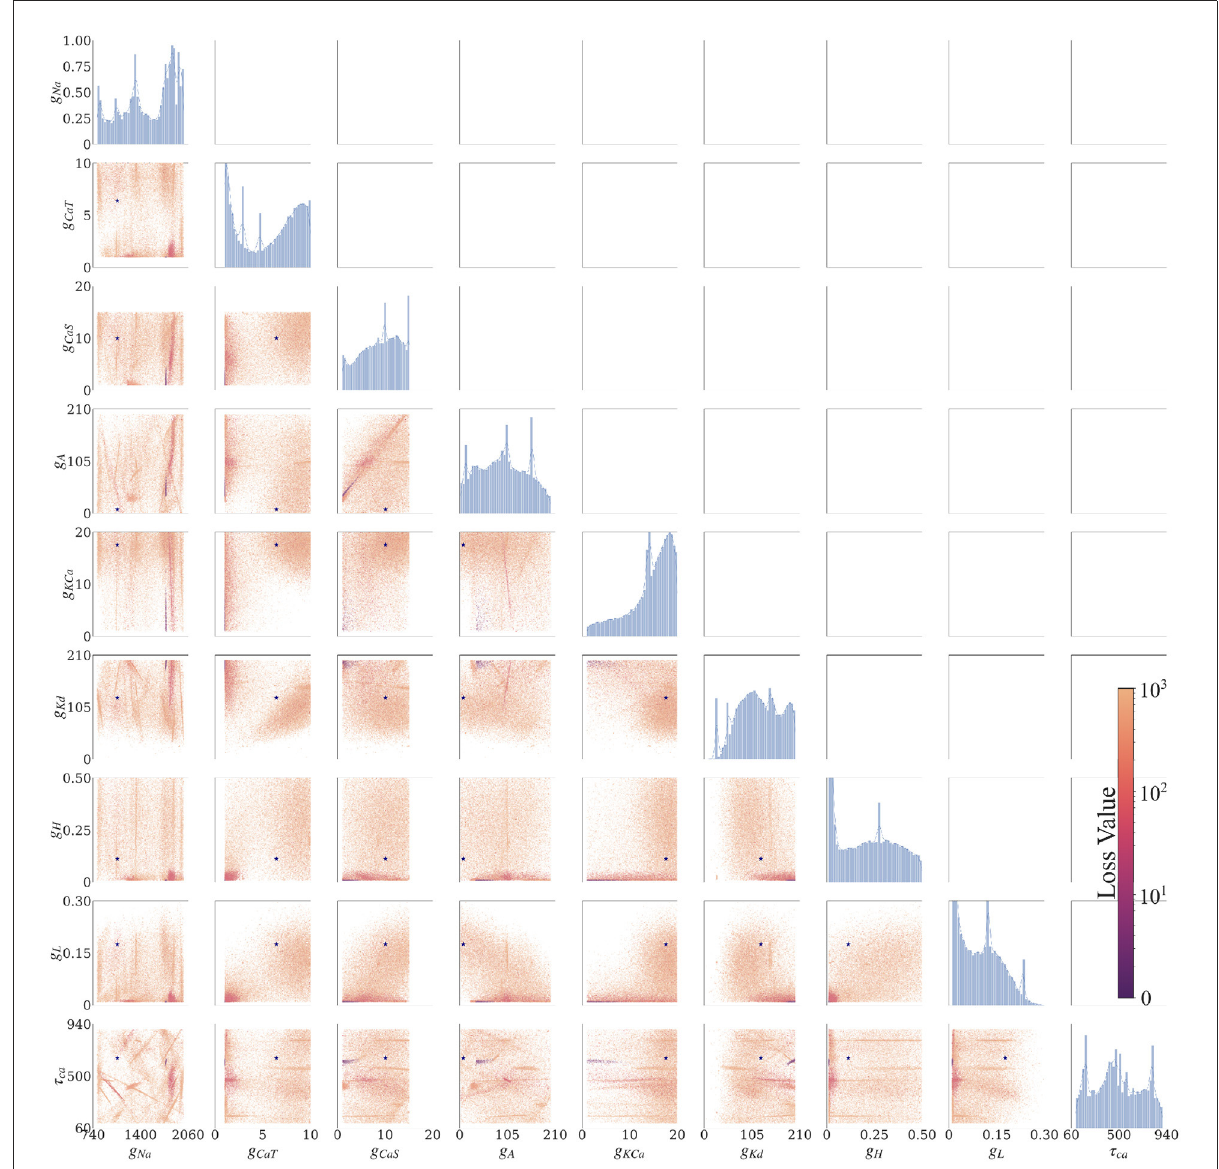
FIGURE4 Solution maps of the posterior for the 9 parameters of the AM model for the aggregate constraint. The diagonal plots show the 1D marginals of each parameter. The x-axis is the search range of the parameter, and the y-axis is the normalized distribution. The remaining plots are the 2D marginals of pairs of parameters. The x- and y-axes are the range of the pairs of parameters. Each point within each plot is a sample found by the MCMC algorithm. The colors indicate the associated loss value of this sample, where purple color indicates a lower loss value and yellow color indicates a higher loss value. The density of the points will contribute to the darkness of an area. More pronounced color signifies that more points are overlaid on top of each other. This density can also be traced back to the 1D marginals to the top and the left side. The ground truth values are plotted as a purple asterisk for comparison to low loss modes of the parameter